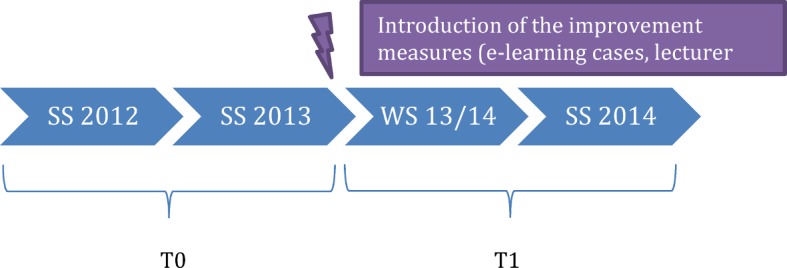
The course design